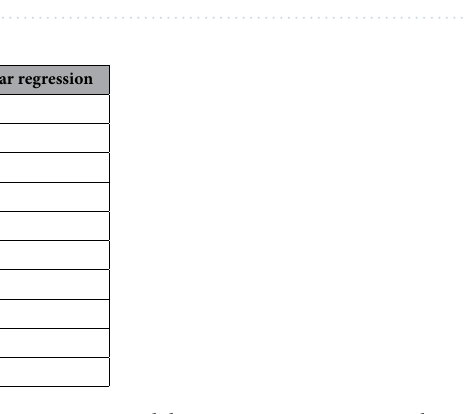
Figure 4. Correlation between SUVmean and Ki for physiological and tumoral uptakes in the whole cohort and according to PET system.